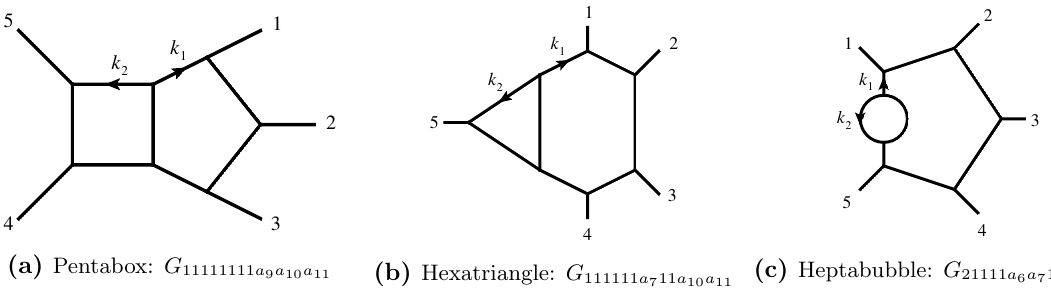
Figure 1. Two-loop (cid:12)ve-point master topologies. All external momenta are considered out-going, arrows indicate loop momenta